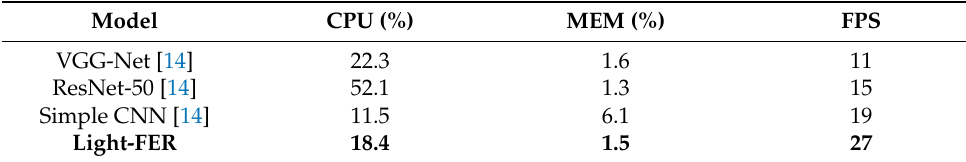
Table 3. Hardware Performance of Different FER Models.